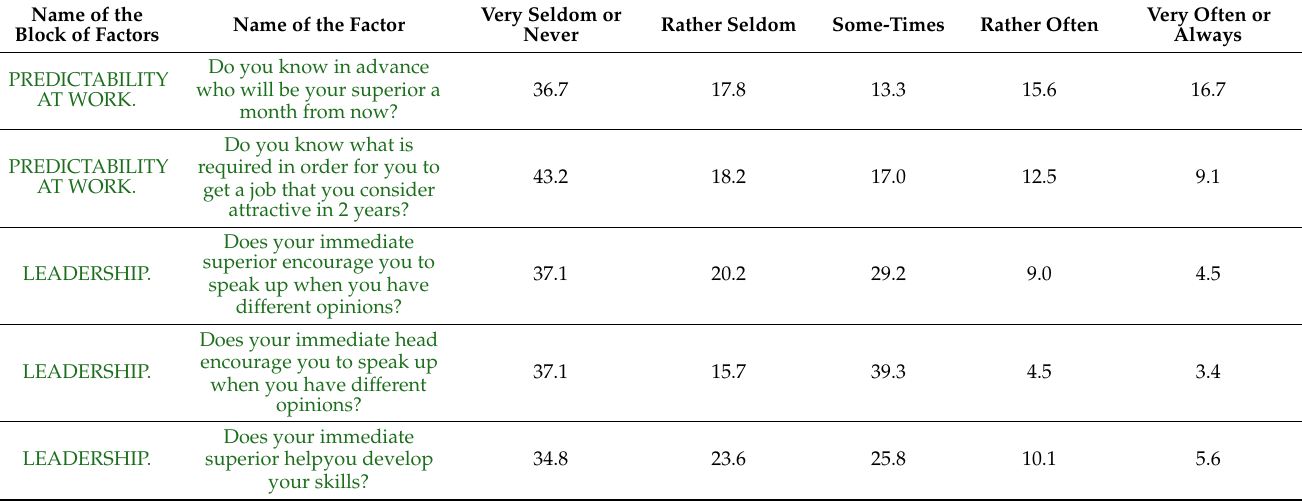
Table 12. Negative psychosocial factors in the work of loggers with shift work organization in the Far North (% of the total